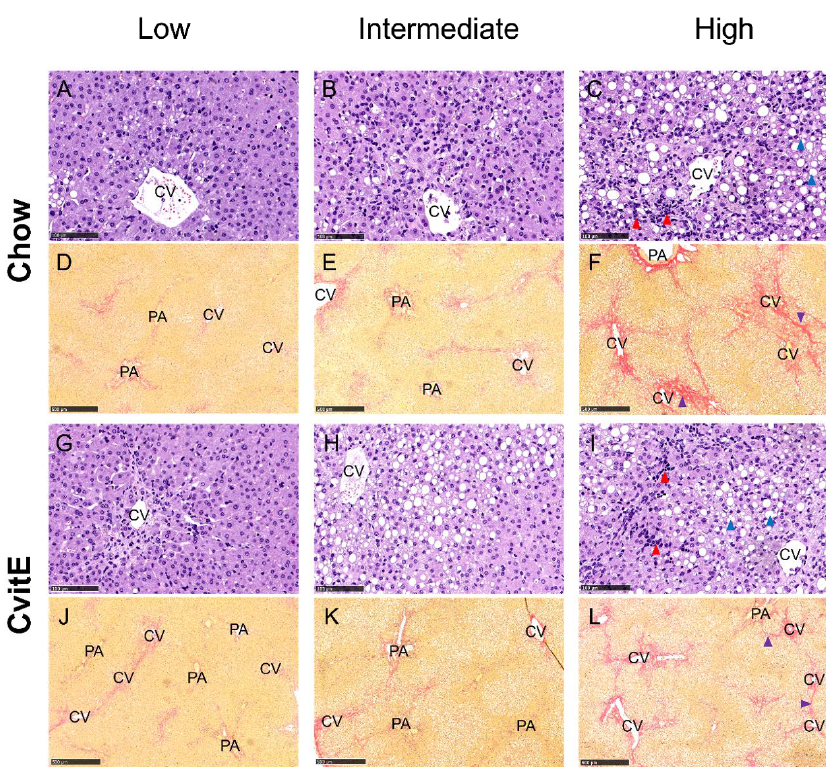
Figure 5. Representative histological images of liver sections at study termination. Panels are divided into subgroups: low (inflammatory score 0); intermediate (inflammatory score 1) and high (inflammatory score 2–3). ( A – C , G – I ) Hematoxylin and eosin stain, scale bar 100 µm. ( D – F , J – L ) Picro Sirius red stain (fibrosis stained red), scale bar 500 µm. The histological images show the pathological lesions associated with NASH: steatosis (macro and micro vesicular) (blue arrowheads), lobular inflammation (red arrowheads) and bridging fibrosis (purple arrowhead). Ballooning hepatocytes were also assessed, however cannot be identified at this magnification. CV, central vein; PA, portal area.